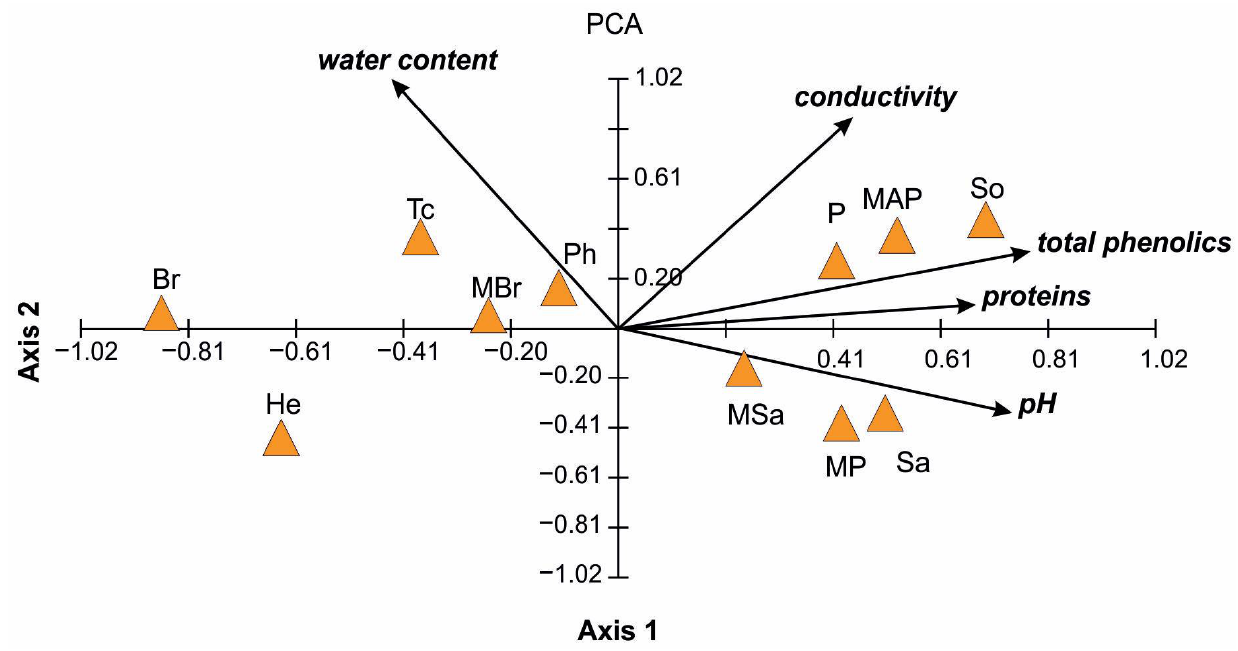
Figure 1. Principal component analysis (PCA) ordination diagram illustrating physicochemical differences among the 11 studied honeys based on five variables (solid line vectors). The variables: total phenolics and pH determined the gradient of axis 1, while the water content of axis 2.